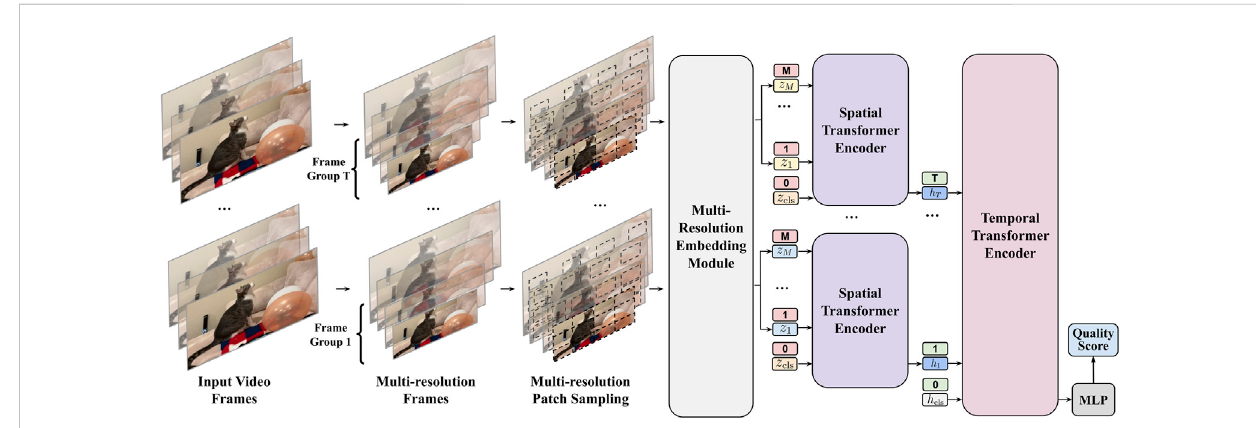
FIGURE 3 Model overview for MRET. Neighboring video frames are grouped and rescaled into a pyramid of low-resolution and high-resolution frames. Patches are sampled from the multi-resolution frames and encoded as the Transformer input tokens. The spatial Transformer encoder takes the multi- resolutiontokenstoproducearepresentationperframegroupatitstimestep.ThetemporalTransformerencoderthenaggregatesacrosstimesteps. To predict the video quality score, we follow a common strategy in Transformers to prepend a “ classi fi cation token ” ( z cls and h cls ) to the sequence to represent the whole sequence input and to use its output as the fi nal representation.